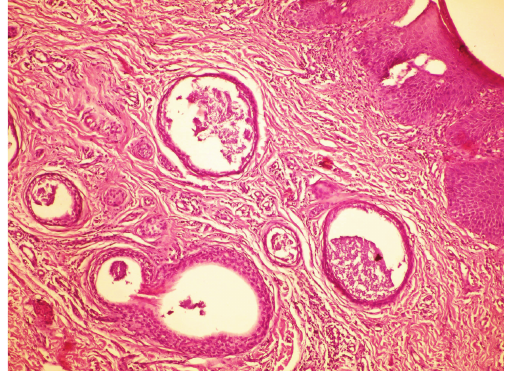
Figure 2: Tumoral lesion consisted of cystic enlargement of two-layered tadpole-like ductal epithelial structures including eosinophilic material, embedded in fibrous stroma (H&E × 200).